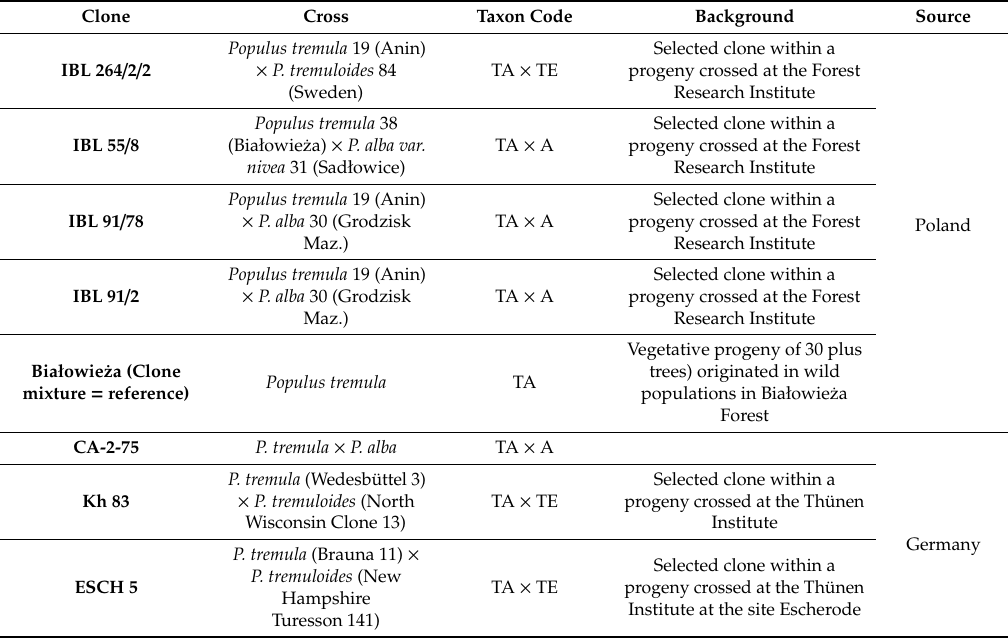
Table 1. Source and parentage of the clones used in the